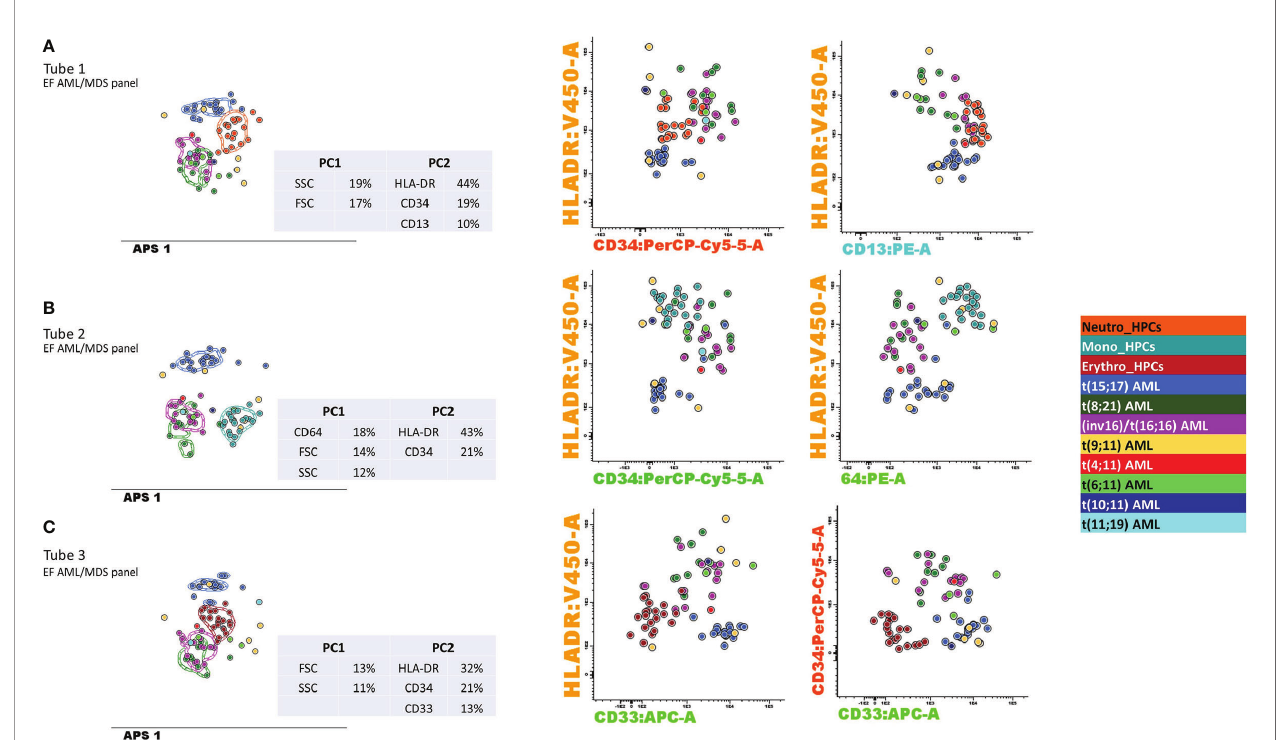
FIGURE 8 | Contribution of markers to the separation of blasts from different AML groups with recurrent genetic abnormalities and myeloid-committed normal HPCs. Samples were stained with antibodies from tubes 1 – 3 of the EuroFlow (EF) acute myeloid leukemia (AML)/myelodysplastic syndrome (MDS) panel. Bivariate dot plots and principal component analysis (APS) diagrams for 20 neutrophil-committed HPCs (orange), 20 monocyte-committed HPCs (turquoise), 20 erythroidcommitted HPCs (dark red), 19 t(15;17) AML cases (blue), 8 t(8;21) AML cases (dark green), 13 inv(16)/t(16;16) AML cases (violet), 5 t(19;11) AML cases (yellow), 1 t(4;11) AML cases (red), 3 t (6;11) AML cases (light green), 1 t(10;11) AML cases (dark blue), and 2 t(11;19) AML cases (light blue). showed good separation between neutrophil-committed HPCs and AML blasts using tube 1 of the EF AML/MDS panel, based on HLA-DR, CD34, and CD13 expression; between monocyte-committed HPCs and AML blasts using tube 2 of the EF AML/MDS panel, based on CD64, HLA-DR, and CD34 expression and between erythroid-committed HPCs and AML blasts using tube 3 of the EF AML/MDS panel, based on HLA-DR, CD34, and CD33 expression. The circles represent the median values of the blast events for an individual case. The dotted line represents the 1 standard deviation (SD) curve for the group, and the solid line represents the 2 SD curve. The tables show the contributions of each parameter to the fi rst (PC1, x -axis) or second (PC2, y -axis) principal components, re fl ected as percentages. (A) tube 1 EF AML/MDS panel; (B) tube 2 EF AML/MDS panel, (C) tube 3 EF AML/MDS